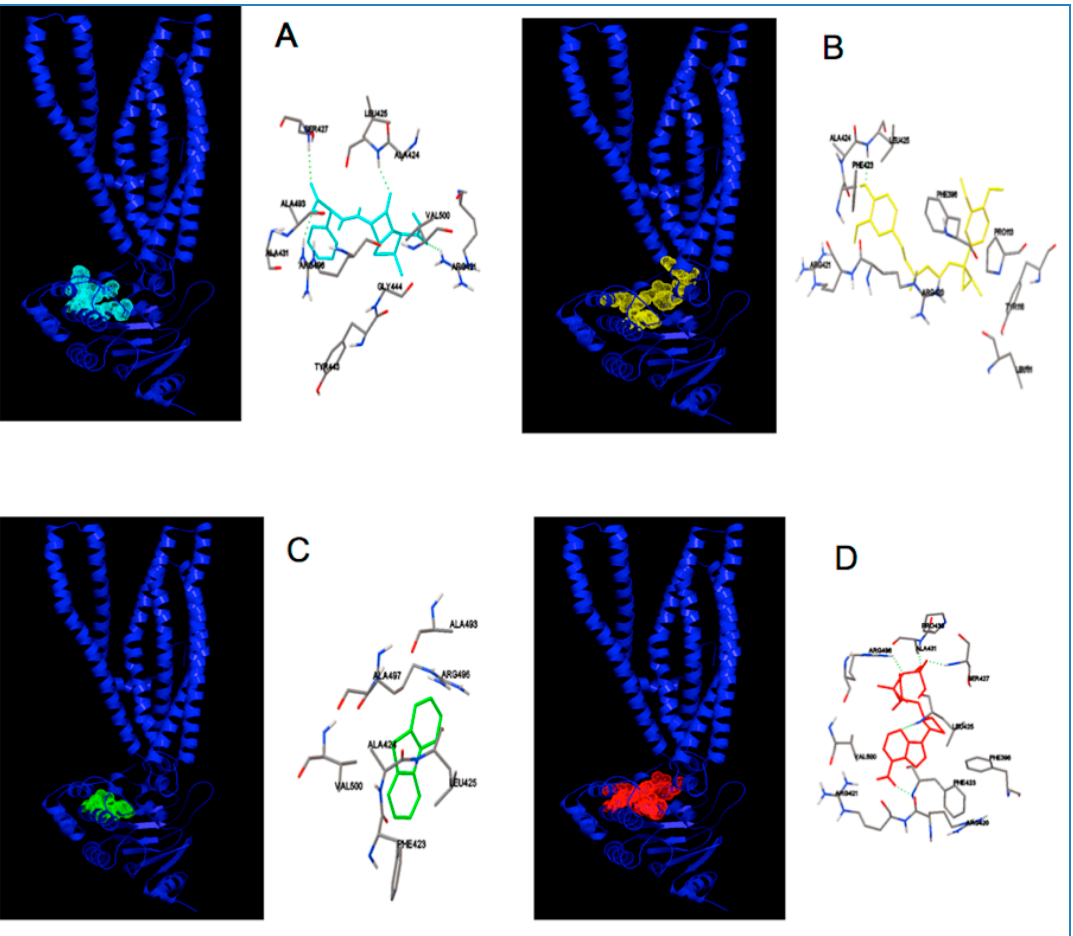
Figure 8. Modeled interactions of the PA1113 ABC transporter with carbenicillin (light blue), verapamil (yellow), dibenzothiophene (green), and ATP (red). ( A–D ) show the general views of the binding of the PA1113 gene product to carbenicillin, verapamil, dibenzothiophene, and ATP, respectively. Detailed views of the binding site showing the principal amino acids potentially involved in the binding of carbenicillin, verapamil, dibenzothiophene, and ATP; ARG421, PHE423, ALA424 and LEU425 are implicated in binding with the different substrates.